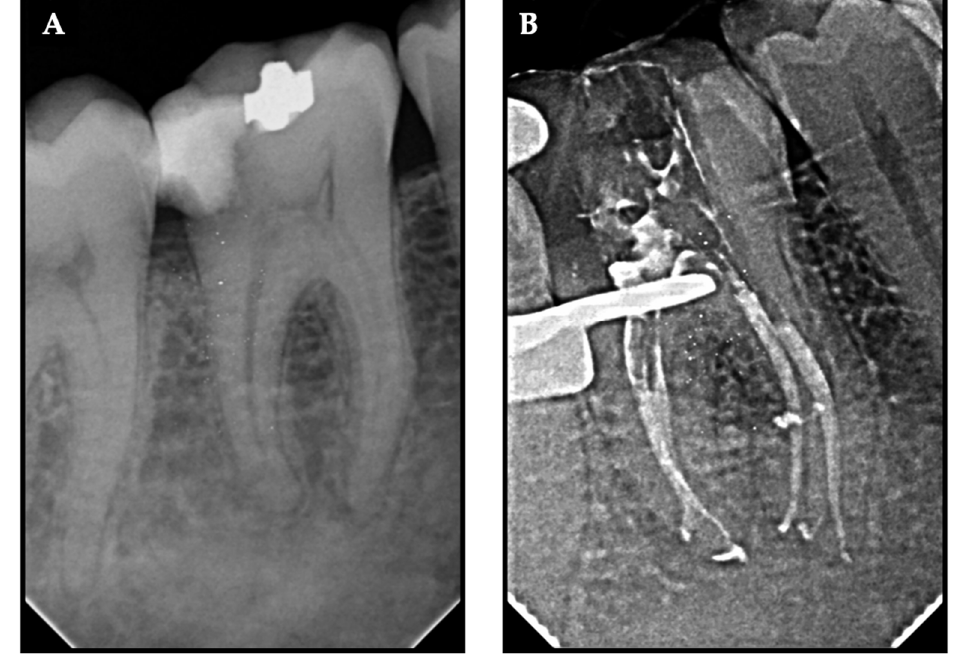
Figure 3. Representative radiovisiographs (RVGs) of ( A ) pre-operative and ( B ) post-obturation X-ray exhibiting sealer extrusion.